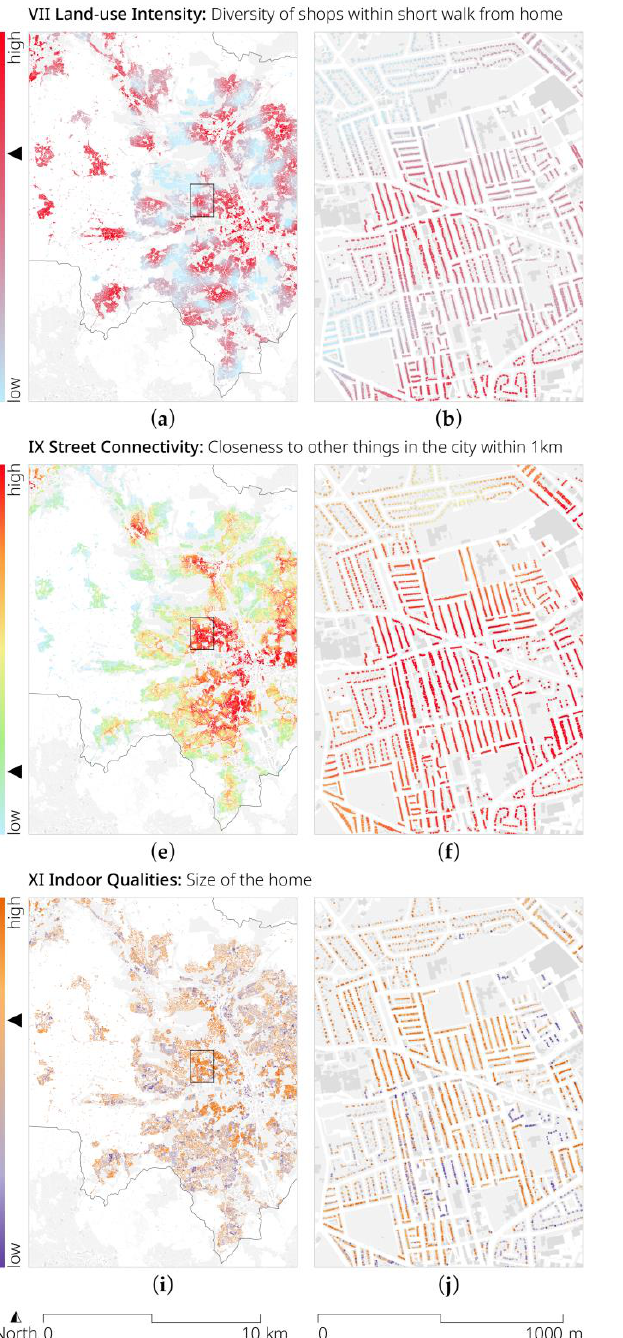
British Pakistani girl. She lived with her two parents in a 5.70 m high mid-terrace house 182 cars and exposed to 9.01 micrograms per cubic metre of particulate matter 2.5, which